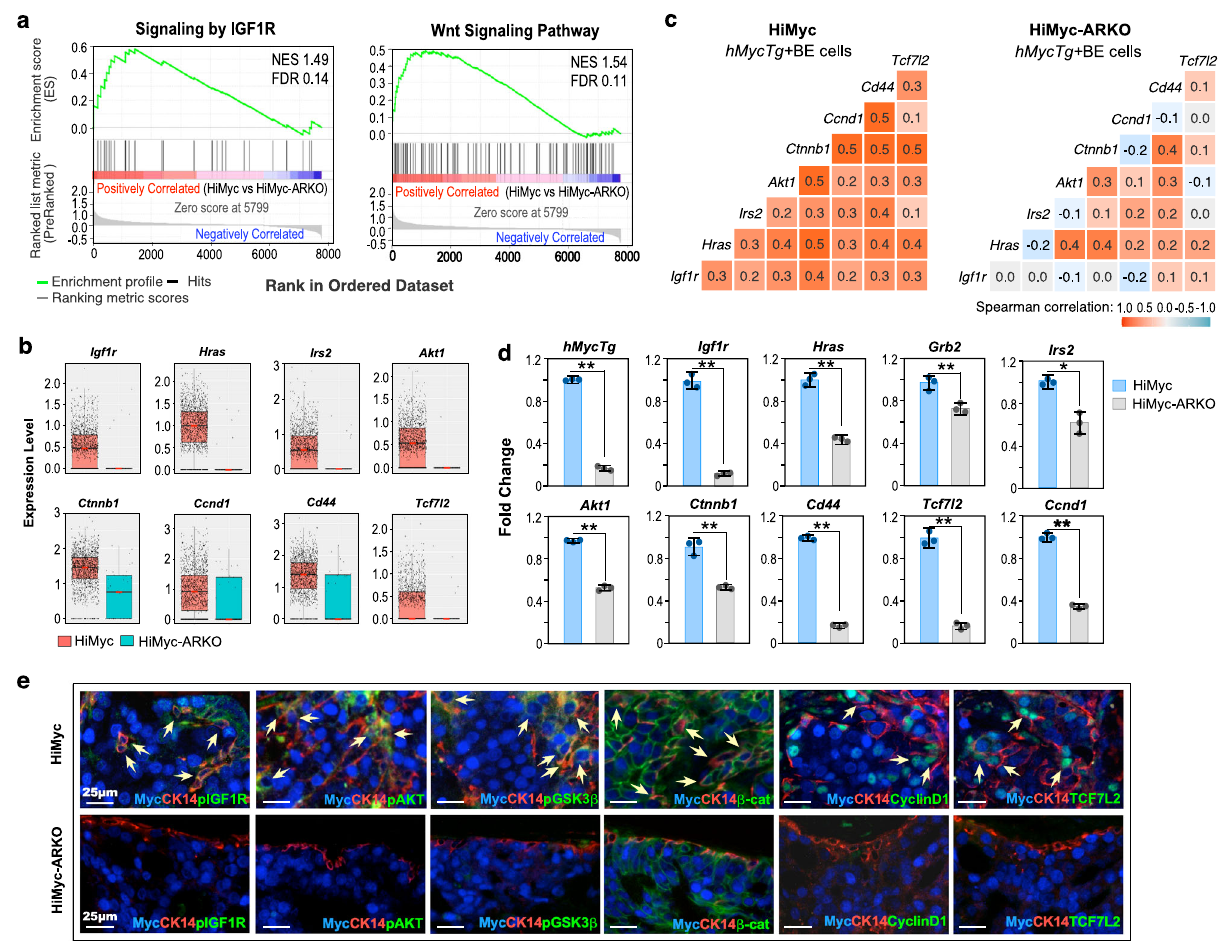
Fig. 4 | Loss of AR in Gli1-lineage cells reduces IGF and Wnt signaling in basal epithelialcells.a GeneSetEnrichmentAnalysis(GSEA)enrichmentplotsdepicting insulin-like growth factor 1 receptor (IGF1R) and Wnt signaling pathways sig- ni fi cantlyup-regulatedin hMycTg + basalepithelialcellsin Hi-Myc:R26 mTmG/+ :Gli1 CreER/+ versus Hi-Myc:R26 mTmG/+ :Ar L/Y :Gli1 CreER/+ . See also “ Methods ” section. NES,normalized enrichment score; FDR, false discovery rate. b Box plots representing scaled expression data for IGF1R (top) or Wnt (bottom) downstream genes in hMycTg + basal cells from indicated genotypes (HiMyc, n =1363; HiMyc-ARKO, n =36). Pink linesmarkthemedian;topandbottomlinesofboxesindicatetheboundariesofthe fi rst and third quartiles, respectively; the top and bottom whiskers show the maximum and minimum values, respectively, excluding outliers. c Heatmap of